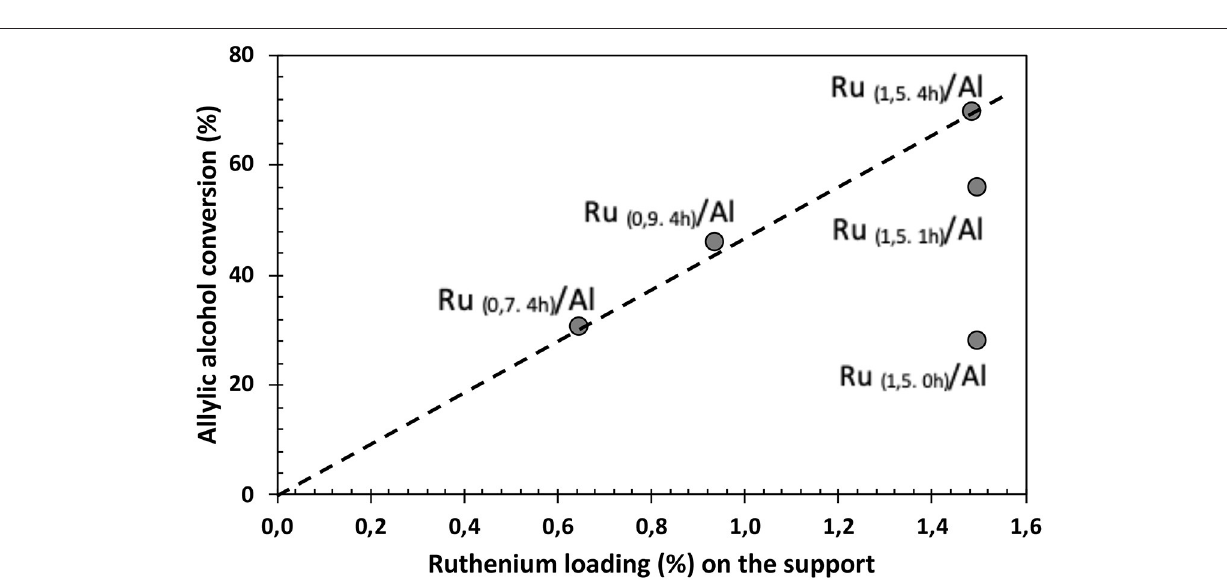
Frontiers in Chemistry |